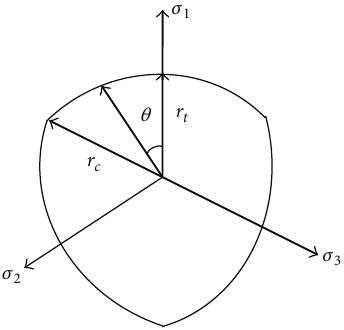
Figure 3: Typical deviatoric cross section of strength surfaces